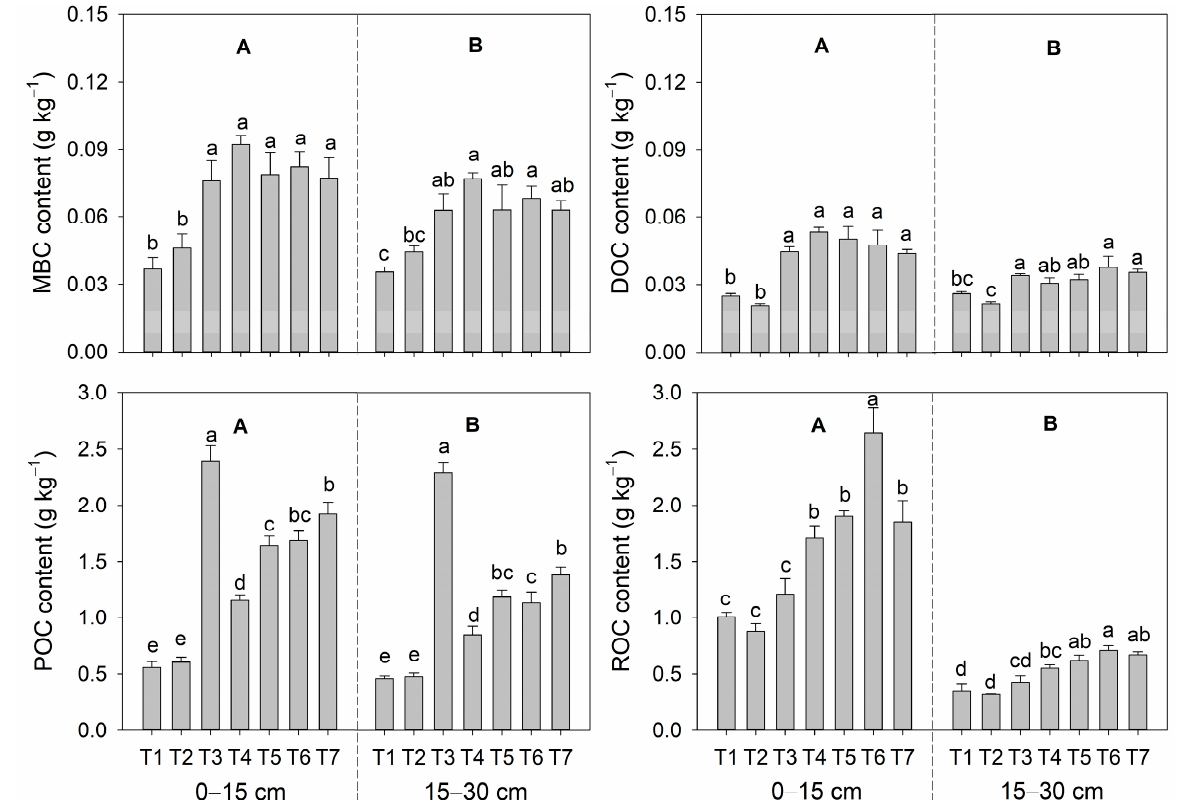
Figure 2. Microbial biomass carbon (MBC), dissolved organic carbon (DOC), particle organic carbon (POC) and KMnO 4 -oxidizable carbon (ROC) contents at 0–15 and 15–30 cm depths as affected by different treatments in 2020 after 12 years of annual fertilization. T1: N application by farmers (240 kg N ha − 1 ); T2: optimized N management (Nopt); T3: biochar + Nopt; T4: straw + Nopt; T5: manure + Nopt; T6: compost + Nopt; T7: biogas residue + Nopt. Lower-case letters indicate significant differences among treatments at a specific soil depth at p < 0.05 level. Capital letters indicate significant differences between the two soil depths at p < 0.05